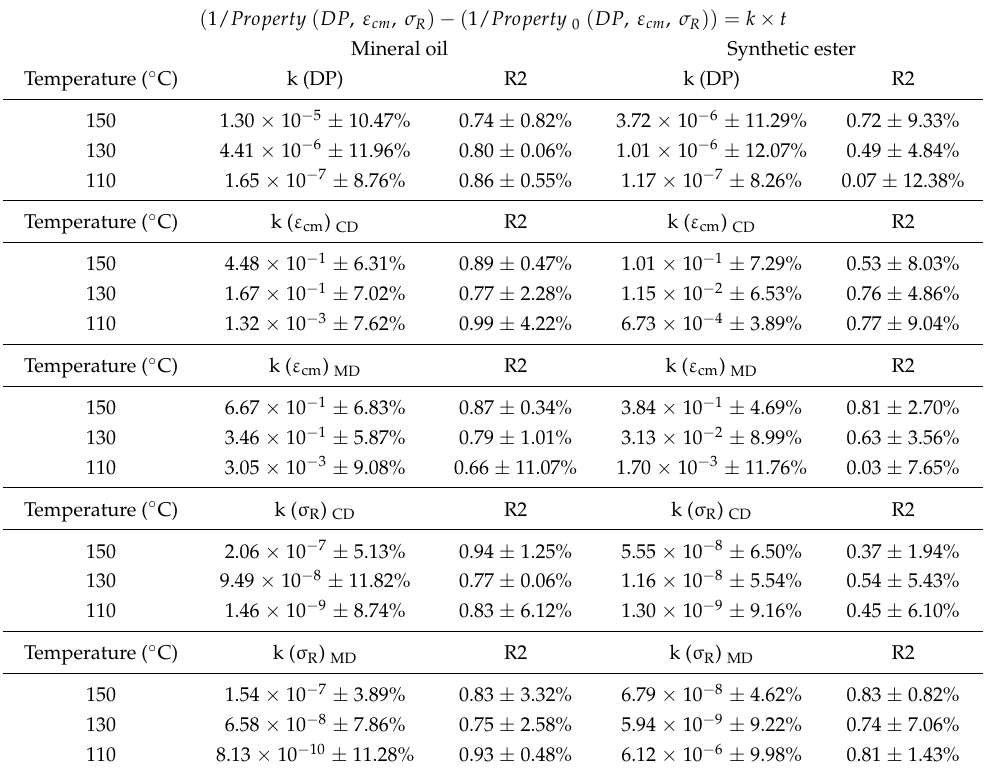
Table 4. Constant rates of reaction for Ekenstam model based on DP, ε cm, and σ R for different insulation